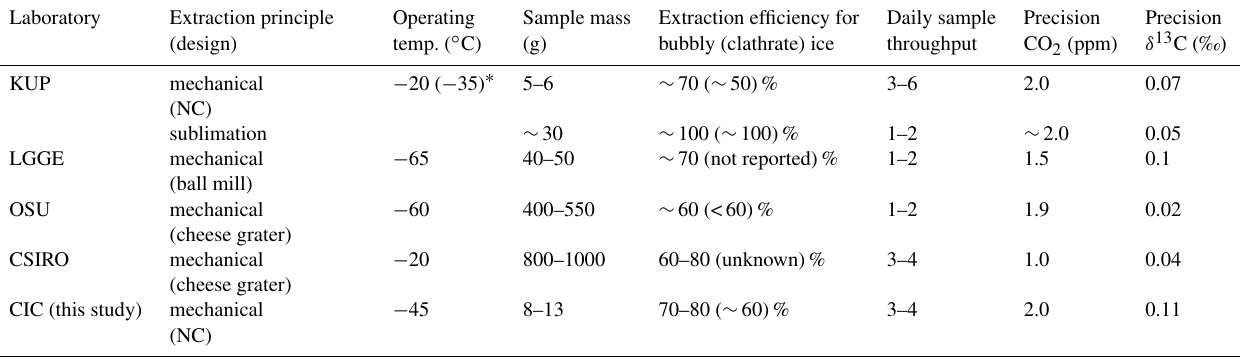
Table 1. Characteristics of published and recently operated analytical systems allowing measurement of CO 2 mixing ratios and the CO 2 stable isotopic composition on a single ice sample. Indicated precisions (1 σ) are estimated from replicate analysis of natural ice samples. One should note that the thereby applied metric may not be entirely comparable (e.g. replicates either measured on different or on the same